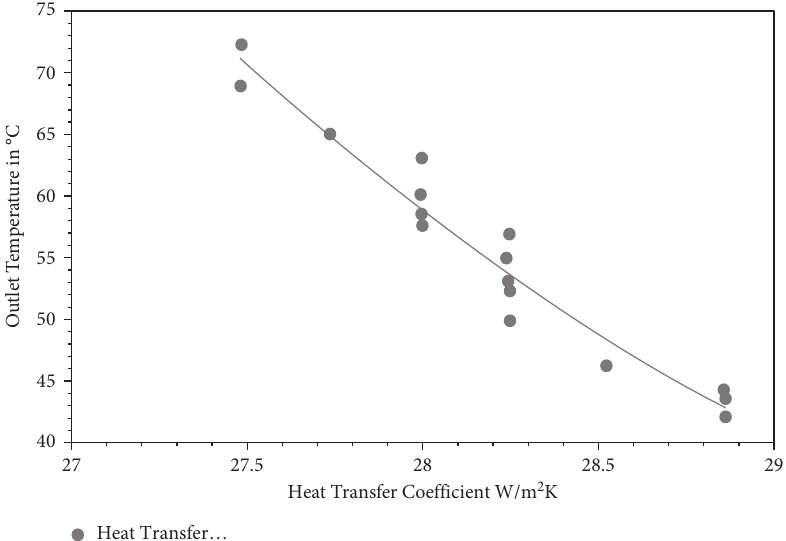
Figure 7: Heat transfer coefcient variation with outlet temperature of